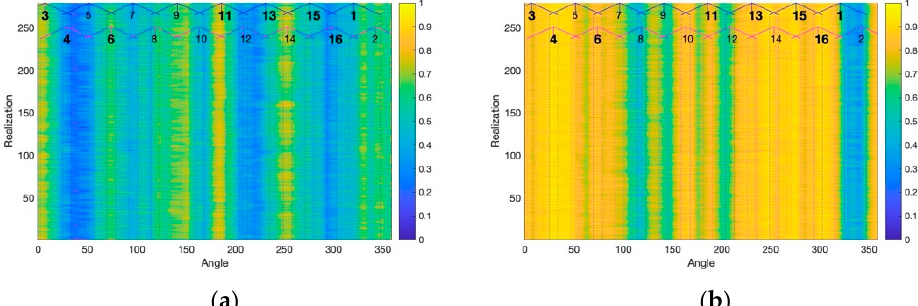
Figure 7. The wavelet bicoherence integrated feature (IWB) of the vibration signals recorded at the beginning of the endurance test ( a ) and at the end of the endurance test ( b ).